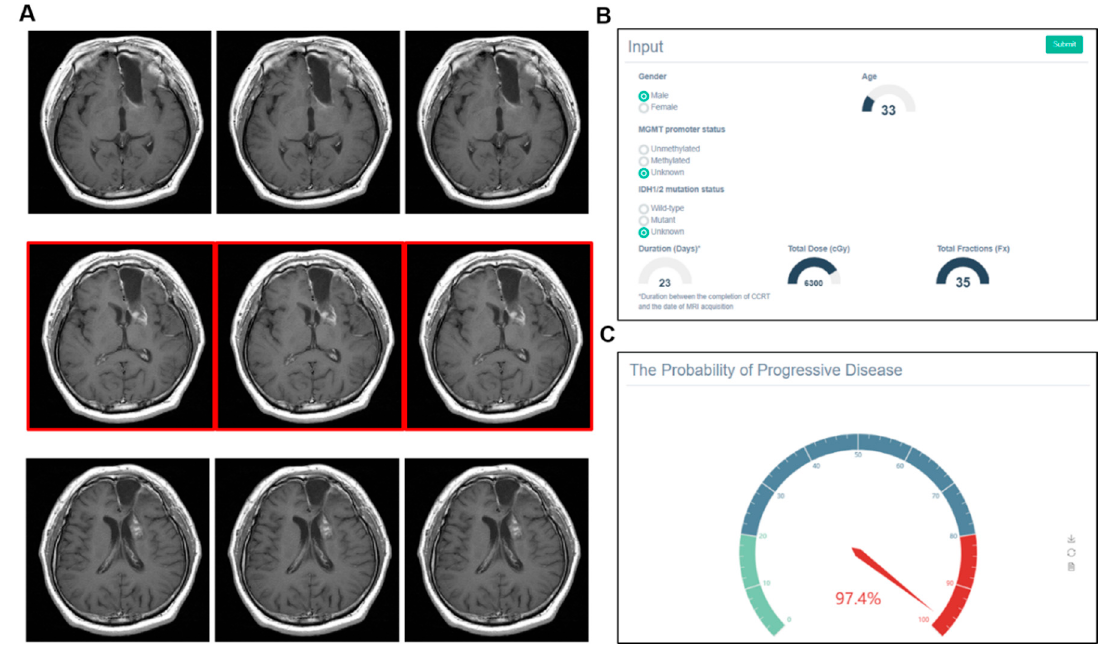
Figure 7. Example of incorrect prediction by the model. ( A ) Triplicate use of MR images was applied due to the thick slice thickness (>1 mm). ( B ) Statuses of the MGMT promoter and IDH were unknown. ( C ) Model predicted a contrast-enhanced lesion from the left genu of the internal capsule as progressive disease with a high probability (97.4%). However, pseudoprogression was the actual diagnosis.